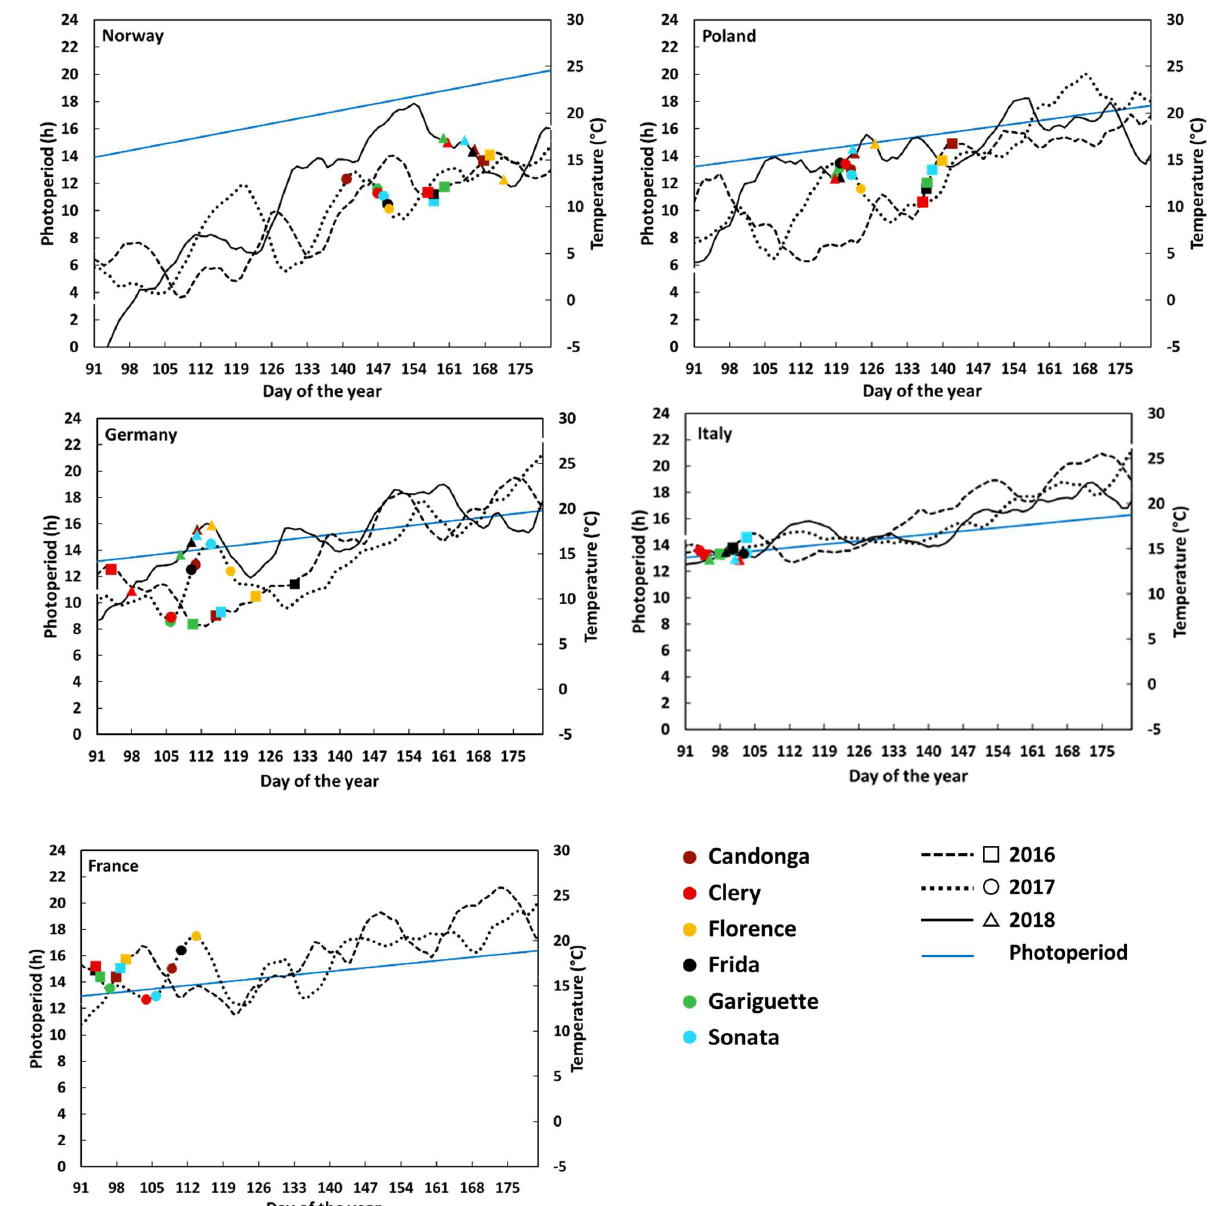
Figure A3. Day of anthesis of six cultivars grown at five locations in Europe as influenced by temperature and photoperiod for 3 years. Data are presented as running means of 7 days.